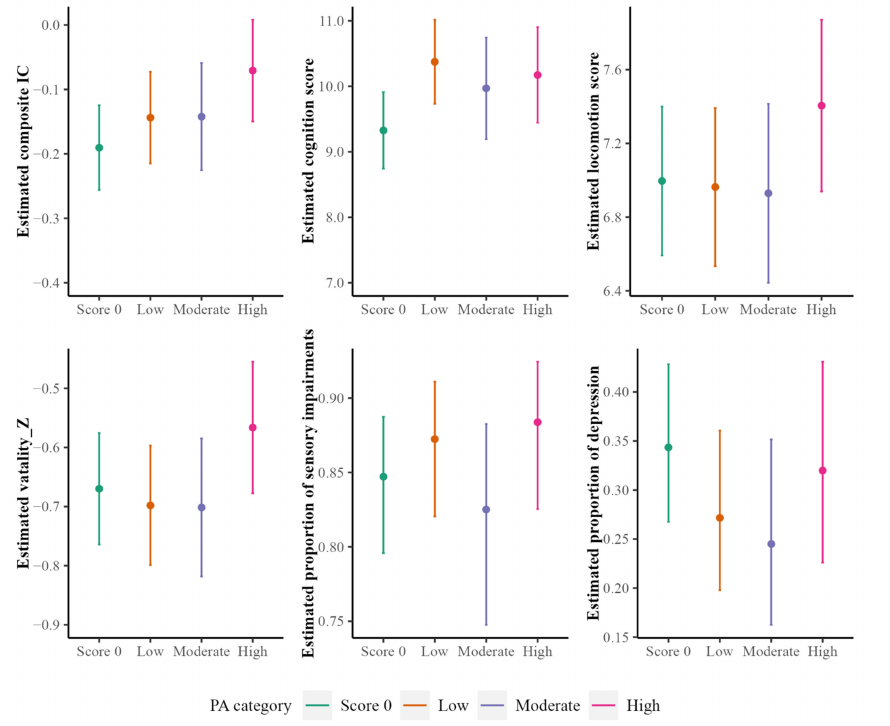
Figure 4. Estimated general IC scores (and scores/proportion for each of the five IC domains) with 95% confidence intervals (CIs) versus LPA levels. The estimation is based on a linear mixed-effects model for continuous outcomes and a generalized linear mixed-effects model for binary